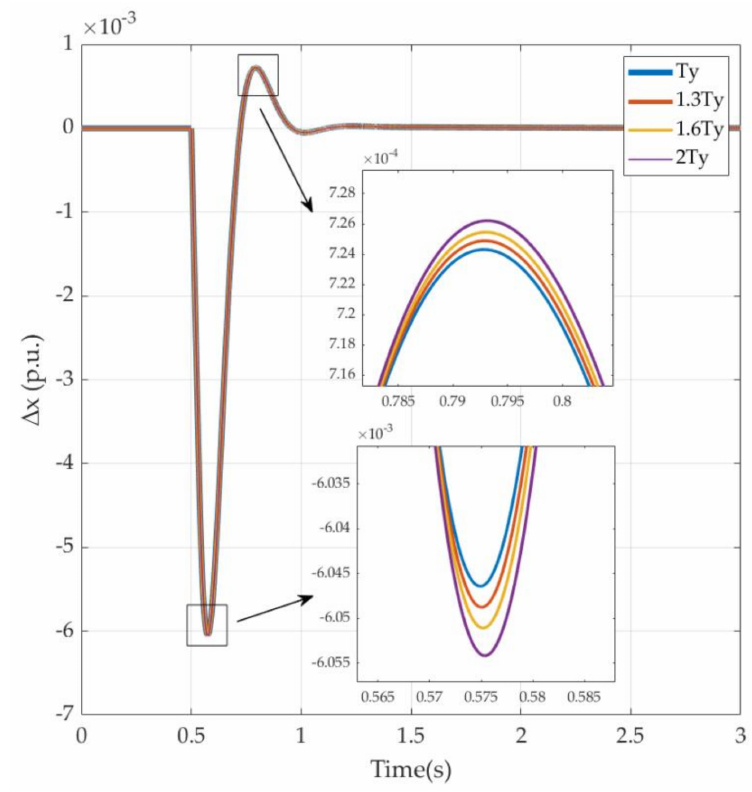
Figure 20. The control effect of the controller when T y changes ( ∆ x − t )